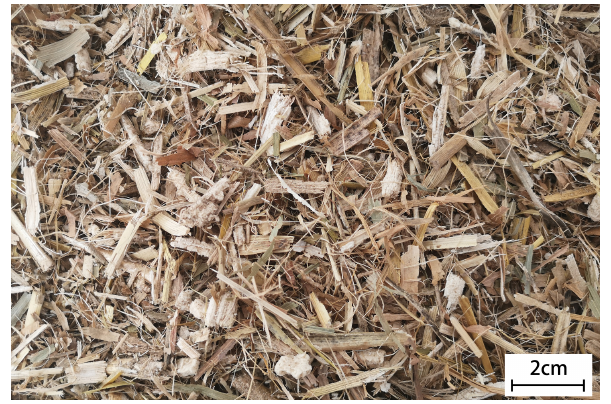
Figure 9. Corn straw with length ≤ 5cm.